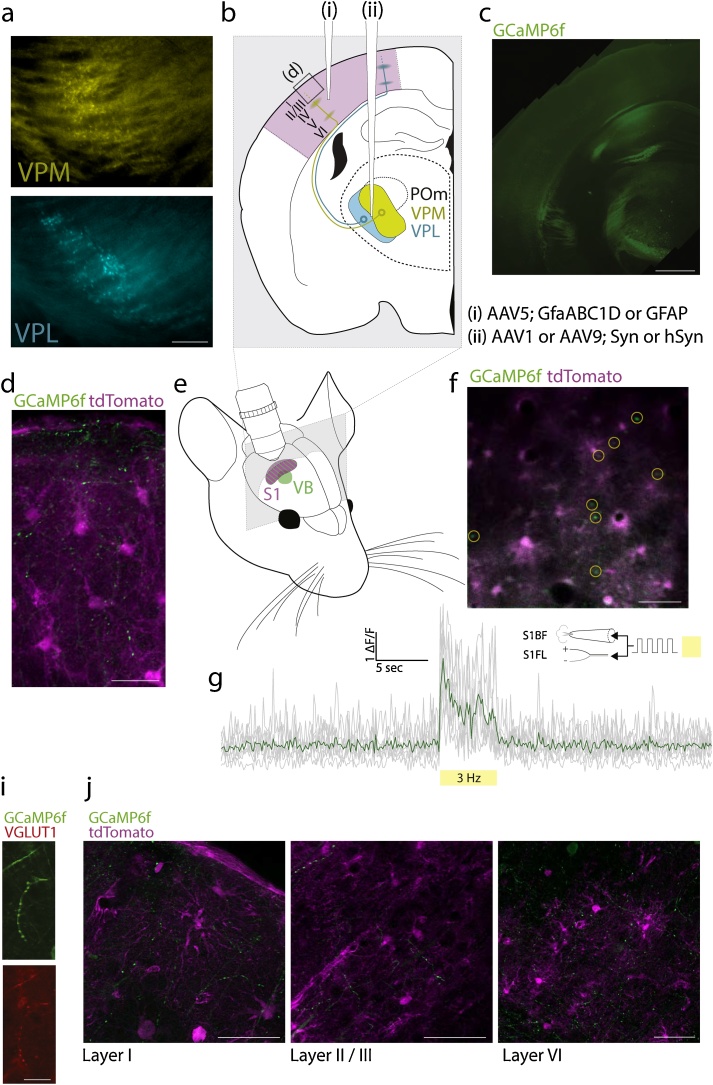
Experimental approach to labelling axonal boutons within the cortical astrocyte arbor. a, regions of the ventrobasal complex of the thalamus identified through retrograde tracing following injection of FluoroGold into the whisker- (top, labelling ventral posteromedial thalamus, VPM) and forepaw-associated regions (bottom, labelling ventral posterolateral thalamus, VPL) of the somatosensory cortex. Scale, 200 μm. b, AAVs were injected into the somatosensory cortex (i) and ventrobasal complex (ii) to label trespassing axons within the arbor of cortical astrocytes. c, VPL injection of viral constructs expressing GCaMP6f. Scale, 1 mm. d, confocal images of immunolabelled fixed cortex (Layer 1, as indicated in b, boxed region) following AAV injections of the cortex and the ventrobasal complex, as outlined in b. Scale, 30 μm. e, experimental setup outlining the targeted regions for labelling the somatosensory cortical boutons and astrocytes, and subsequent multiphoton imaging. f, g Multiphoton imaging of GCaMP6f-positive thalamocortical boutons in the whisker region of somatosensory cortex during tactile stimulation, where astrocytes are also labelled (tdTomato). f is an image projection (layer II / III, depth 100 μm) over the duration of the stimulus and g is the Ca2+-dependent fluorescence in the highlighted boutons (f, yellow ROIs). Scale, 50 μm. i, j confocal images of immunolabelled fixed cortex. VGLUT1-positive boutons were observed throughout the cortical layers. Scales, 15 μm (i) and 50 μm (j).